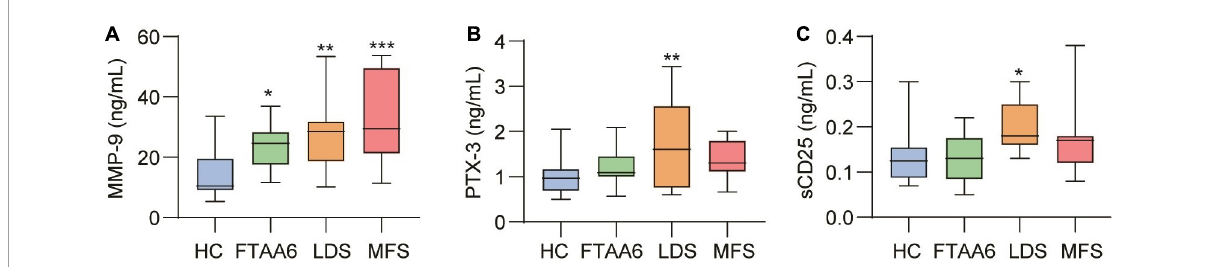
FIGURE1 Results from EIA analyses of (A) MMP-9, (B) PTX3, and (C) sCD25. * p < 0.05, ** p < 0.01, *** p < 0.001 vs. healthy controls (HC). MMP-9, matrix metalloproteinase-9; PTX3, pentraxin 3; LDS, Loeys-Dietz syndrome; MFS, Marfan syndrome; FTAA6, familial thoracic aortic aneurysm 6.